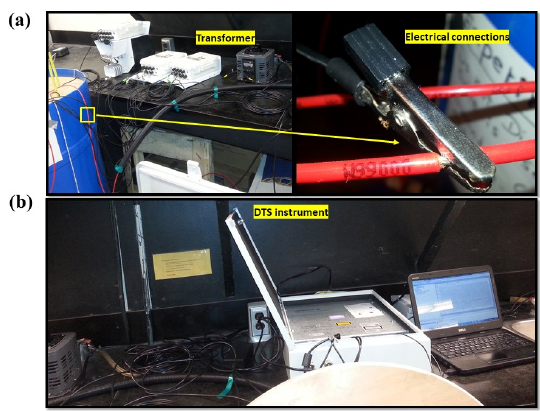
Figure 4. ( a ) An electrical connection (from one side) used to heat up the fiber optic cable, and the variable transformer, which was used to generate the electricity required for different power levels, ( b ) the DTS instrument connected to the computer to record the temperature during the experiment.